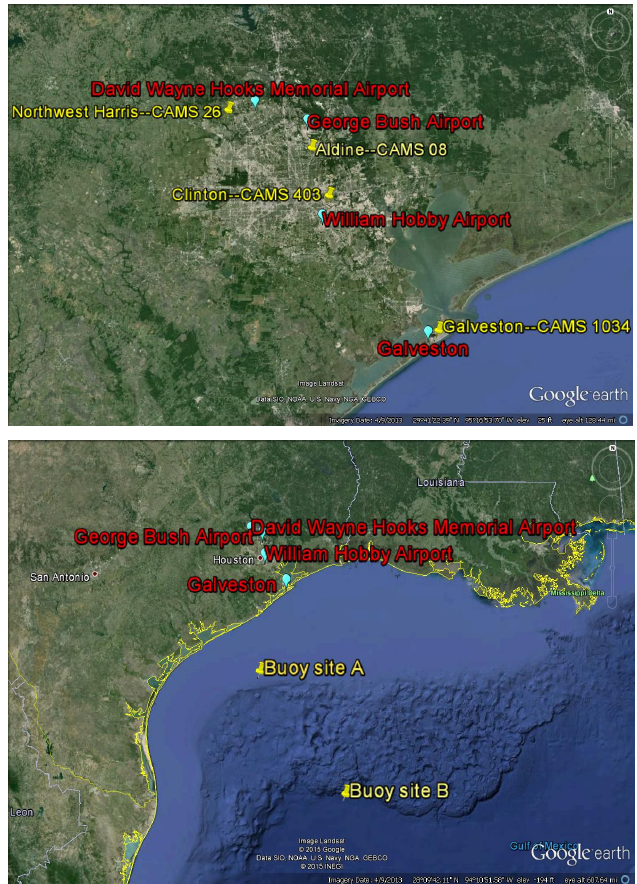
Figure 13. Spatial distribution of study